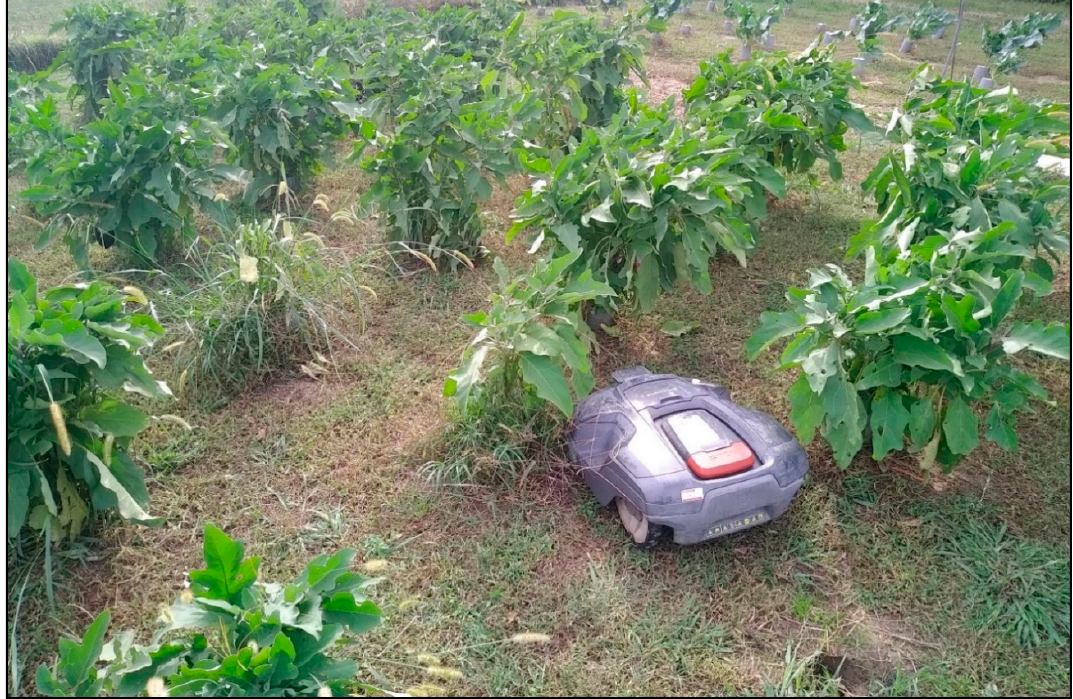
Figure 6. Autonomous mower managing living mulch in aubergine test field at the University of Pisa.